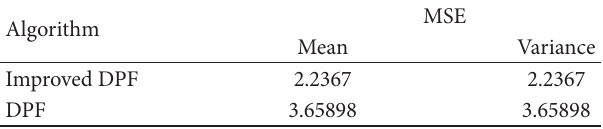
Figure 5: The comparison of estimation results in Experiment 1. Table 1: The comparison of mean and variance in Experiment 1.